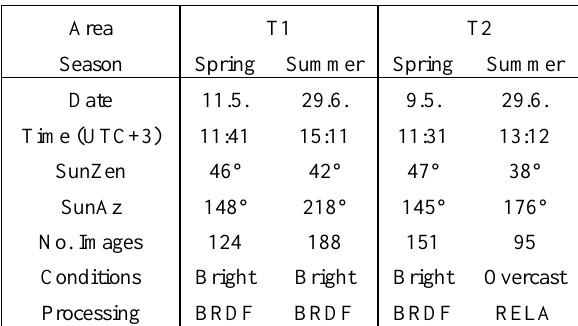
Table 1. 2016 UAS Campaign data used in this study. SunZen = sun zenith angle, SunAz = sun azimuth angle. No. Images = number of images used in image mosaic. Processing = final method used in radiometric processing.